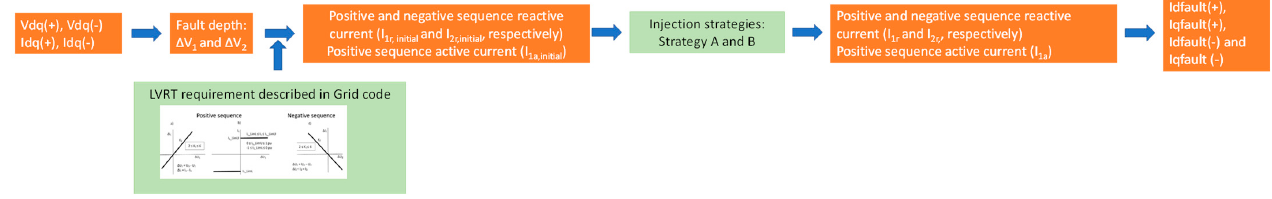
Figure 8. Control methodology to inject positive and negative sequence current.